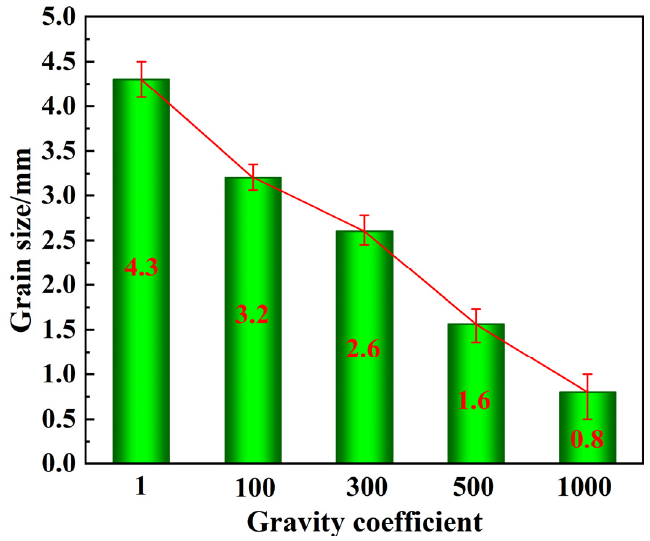
Figure 6. Average grain size of the Cu-0.5Sn alloy under different gravity coefficients.